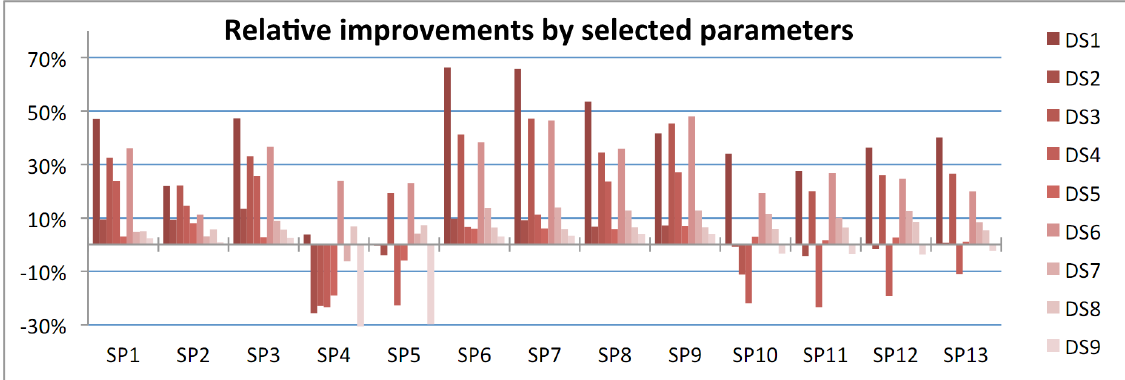
Figure 1: Each selected parameter set (SP) is presented along with its results for each data set (DS). The vertical axis represents the relative improvement in F-score in relation to the baseline value.